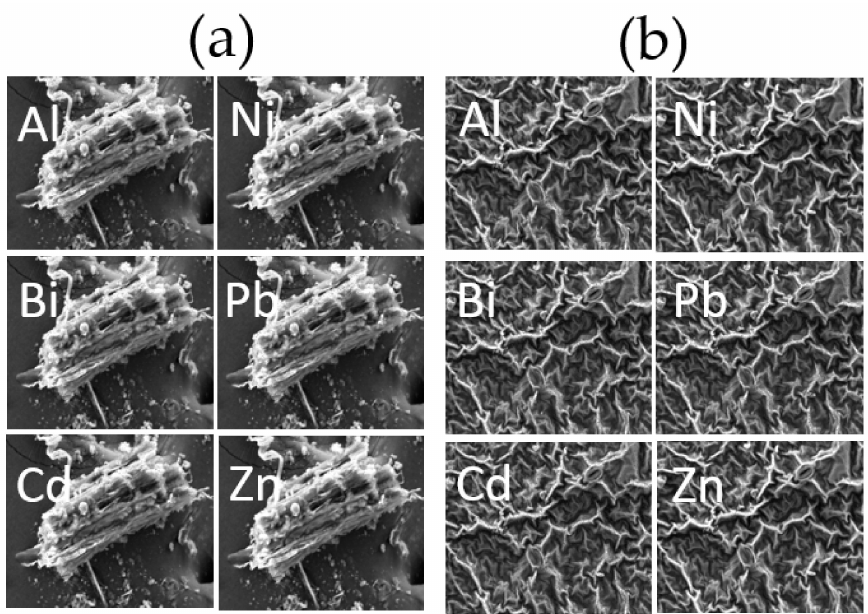
Figure 6. SEM and element mapping image of the ( a ) roots and ( b ) shoots in Taracum officinale (no chelating